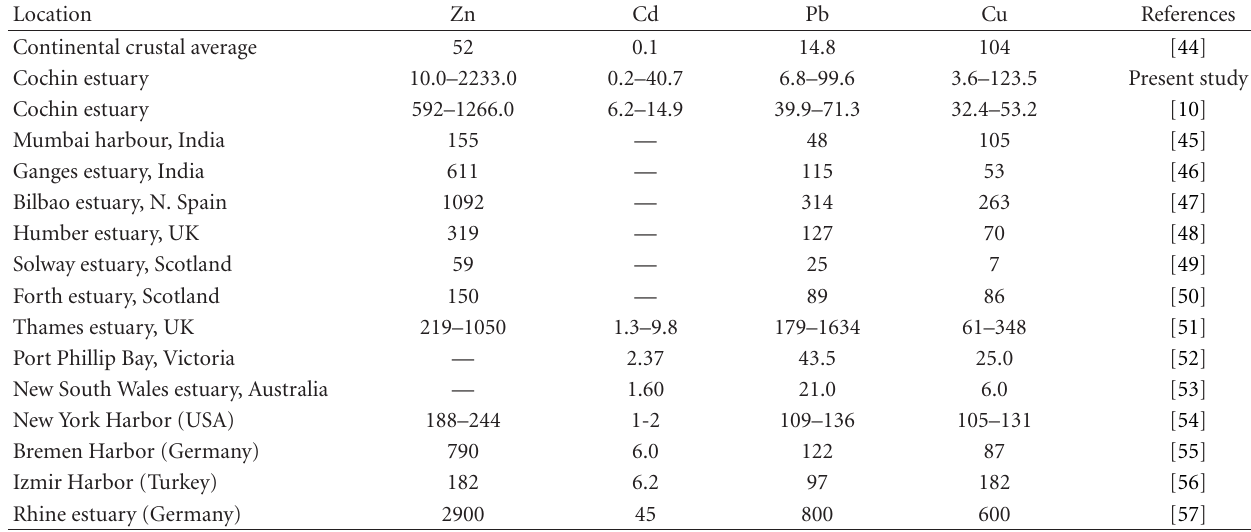
Table 4: Comparison of heavy metal levels (ppm) in the Cochin backwaters to that of other Indian and globally impacted coastal systems.